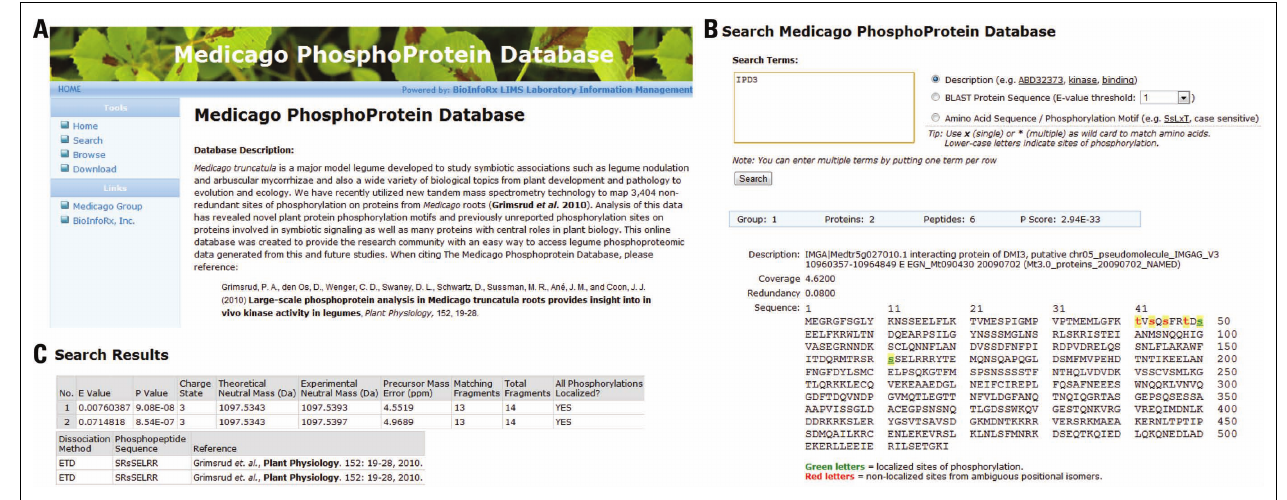
and unlocalized phosphosites, respectively. (C) Selecting amino acid s161 displays information related to the mass spectrometric identification of the peptide used to identify the given phosphosite.This page displays the e -value and p -value assigned by OMSSA, the precursor charge state, precursor theoretical mass, precursor experimental mass, precursor mass error, number of matching fragments, number of possible fragments, whether all phosphosites were localized, the dissociation method, the phosphopeptide sequence, and the reference in which the phosphosite was